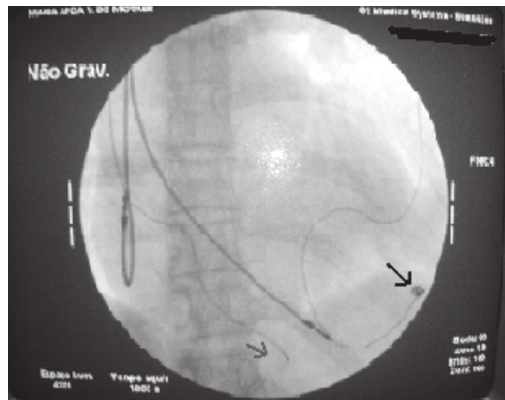
Fig. 5 - Imagem de radioscopia em posição oblíqua anterior esquerda de um paciente que foi submetido a uma re-intervenção para estimulação transvenosa do VE. Observe a seta escura mostrando eletrodo epicárdico abandonado, e a seta clara mostrando o eletrodo transvenoso posicionado em região posterior do ventrículo